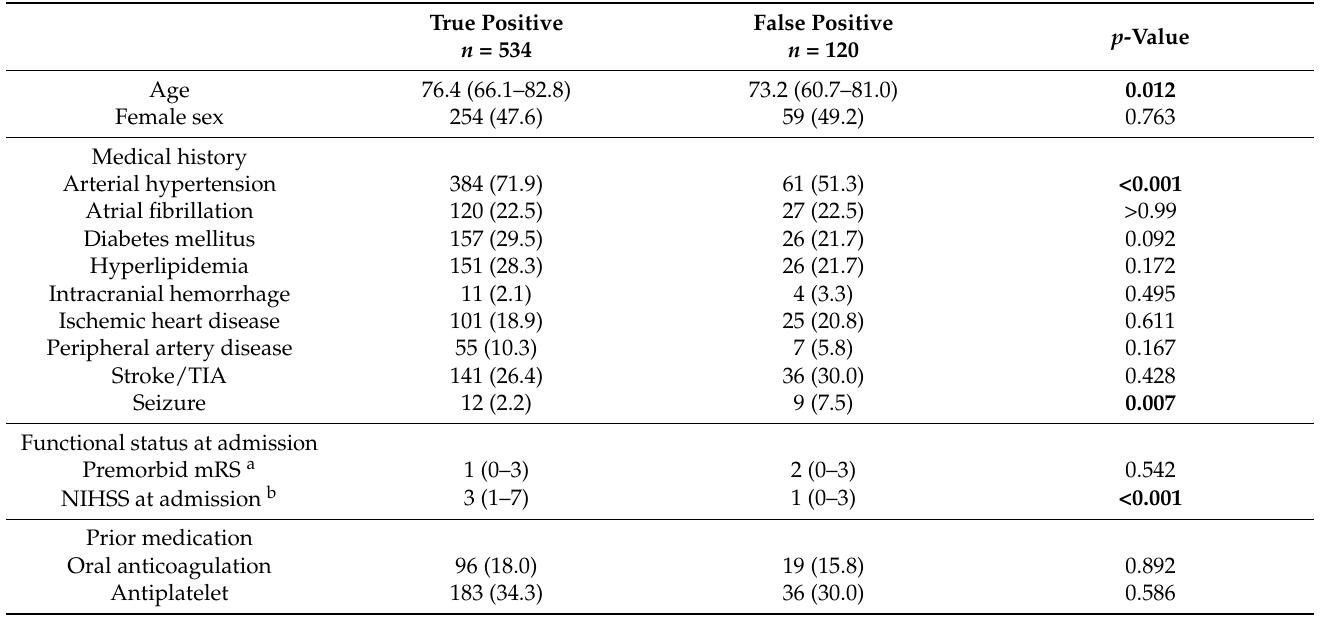
Table A1. Comparison of patient characteristics of true-positive vs. false-positive initial cerebrovascular diagnoses ( n = 654).